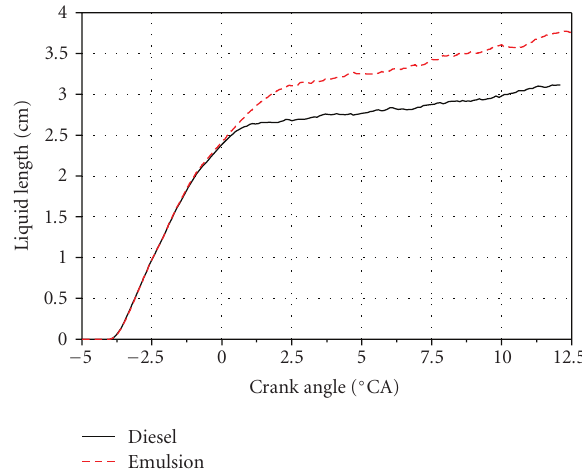
Figure 14: Liquid penetration under nonreacting conditions.